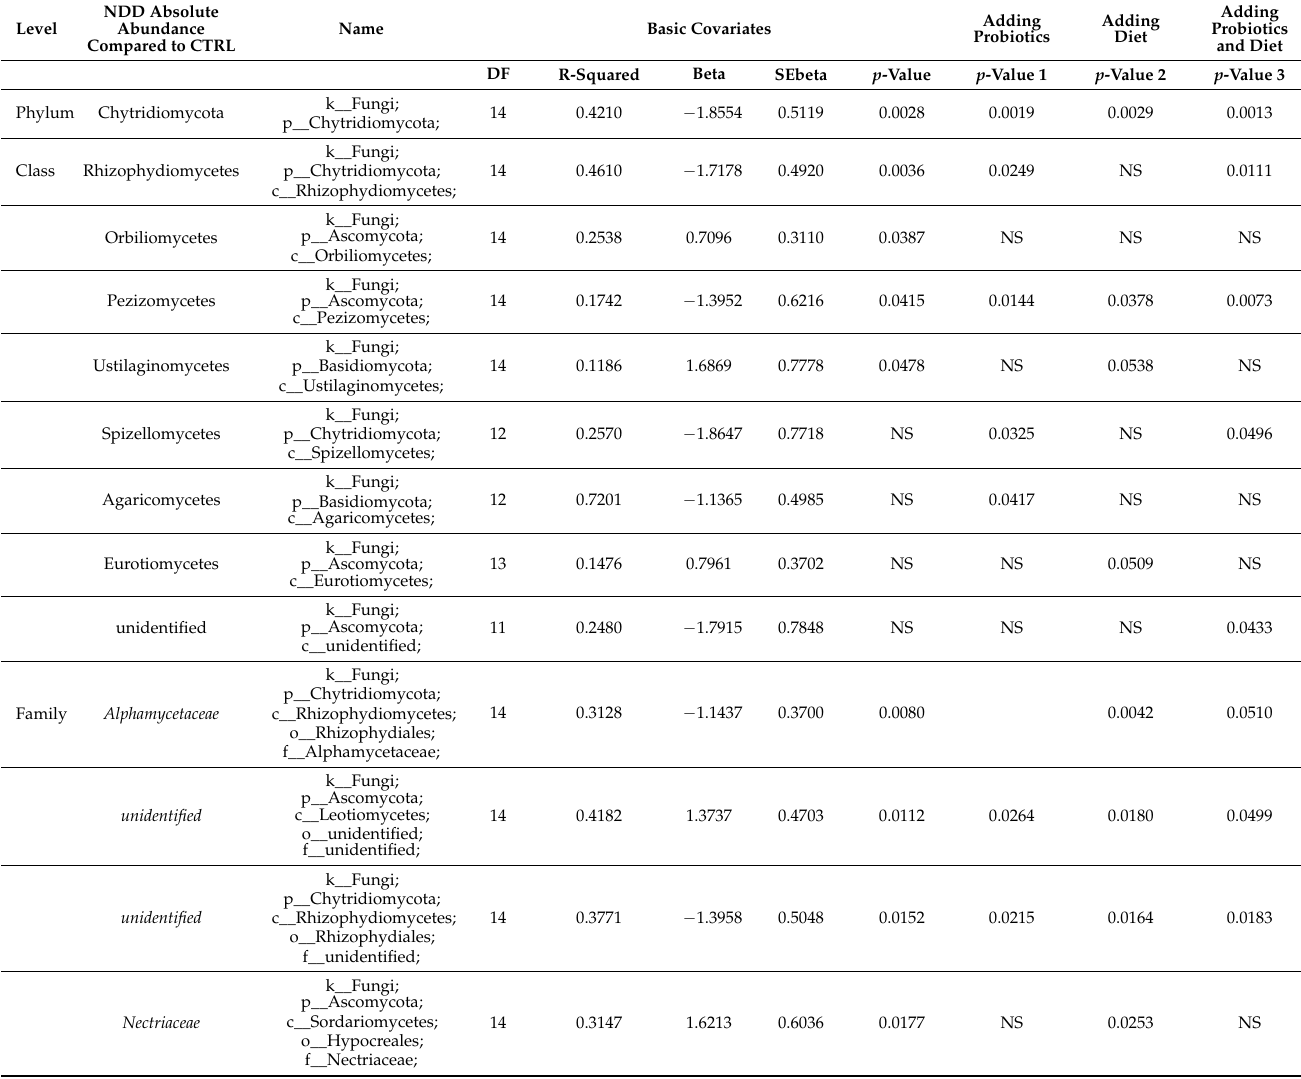
Table A1. Significant changes in abundance of the mycobiome community in NDD are observed at all taxa levels.